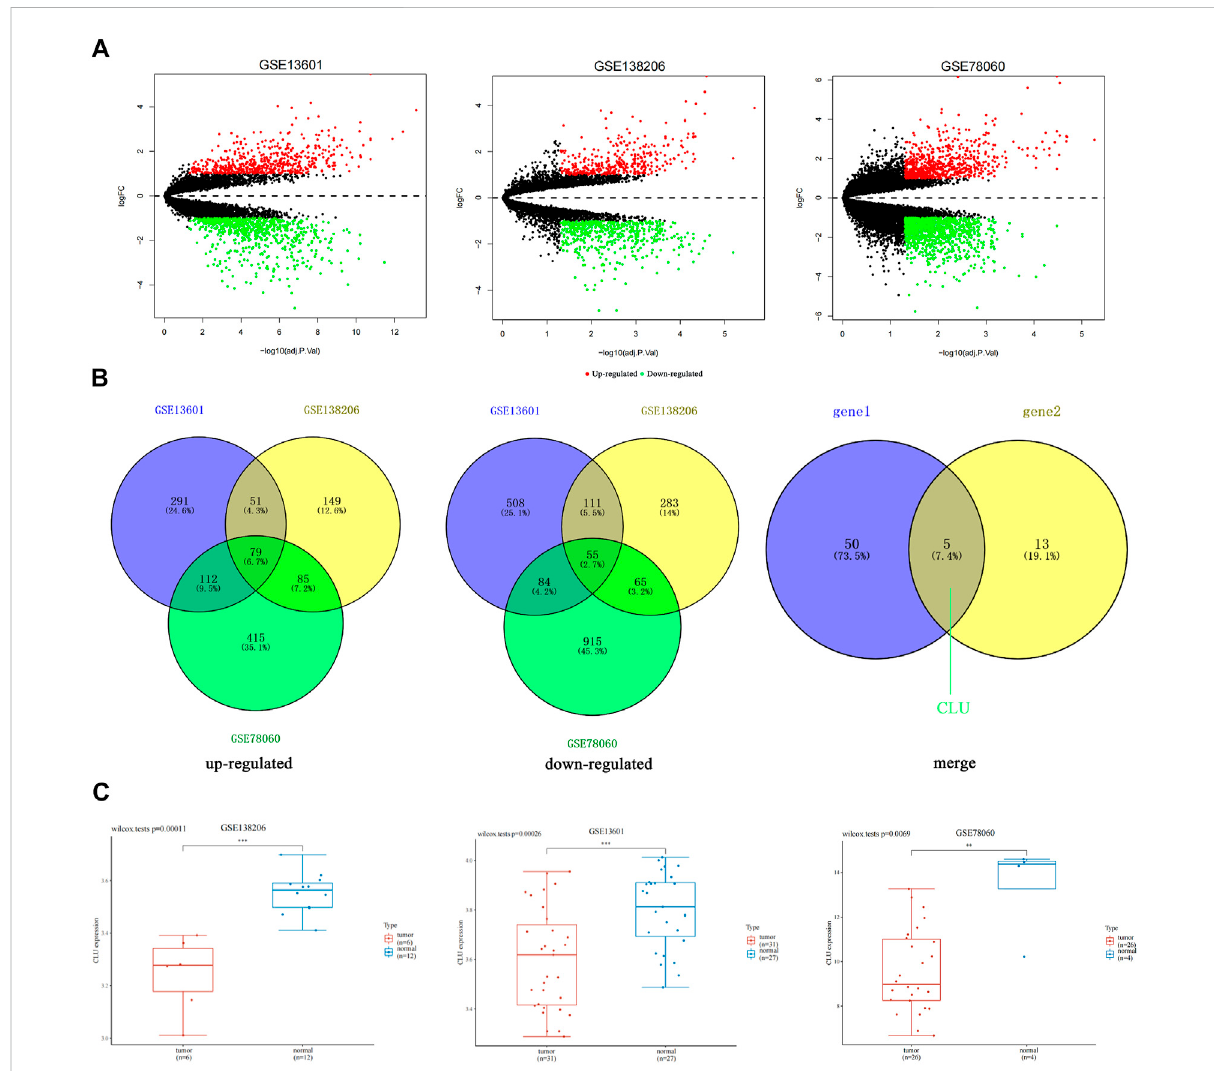
FIGURE 1 Differentiation of gene expression signatures among TSCC datasets from GEO database. (A) The number of DEGs found from the three GEO datasets was shown by volcano plots; (B) Venn diagram demonstrates the intersections of genes among the three GEO datasets; additionally, the intersection between this intersection and the down-regulated genes in the whole gene transcriptome data; (C) the box plot illustrated the expression distribution of CLU in tissues, where the upper left corner displays the p -value for signi fi